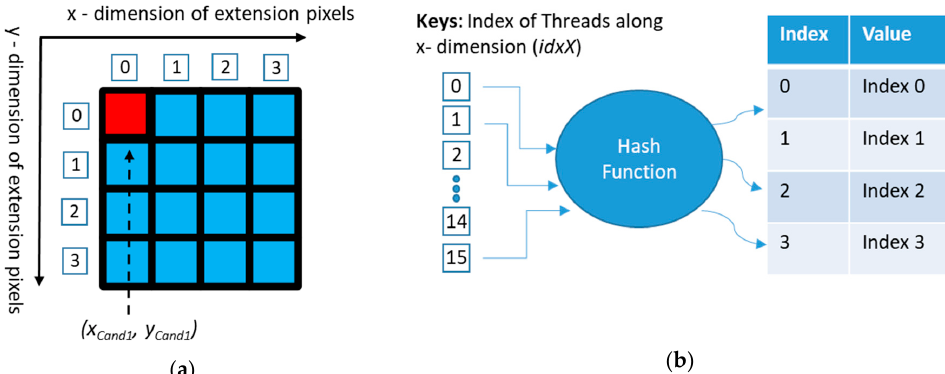
Figure 6. Finding index of the extension pixels using the hash table in the location refinement matching process running on the graphics processing unit (GPU) (figure displays a demonstration of the pyramid up-sampling with level 2, N P = 2). ( a ) Description of coordinate candidate ( x Cand1 , y Cand1 ) and extension pixels; ( b ) description of finding x and y indexes of the extension Algorithm 1 Pseudo-code of location refinement matching